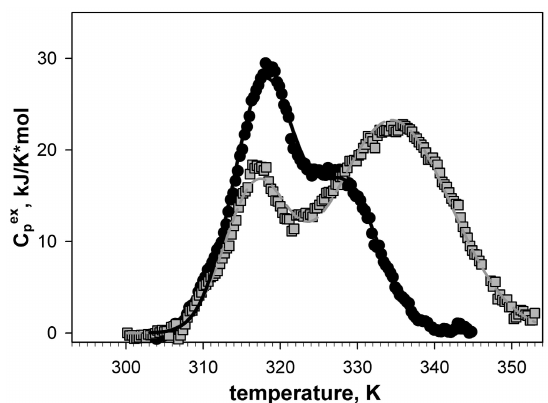
Figure 10. Dependency of excessive heat capacity of wild type G α o protein (circles) and its V82C mutant with disulfide bond introduction (squares) on temperature